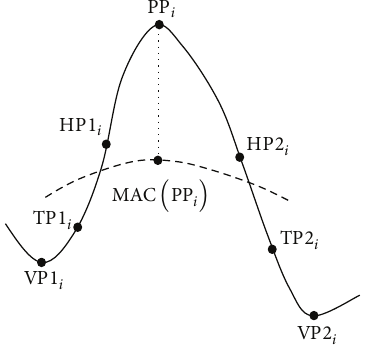
Figure 2: Model-based